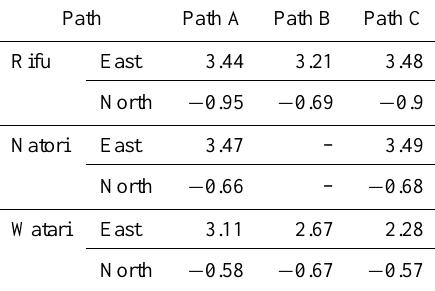
Table 2. Detected 2-D displacements from three image pairs in the sub-areas that contain the GEONET ground stations (units: m).